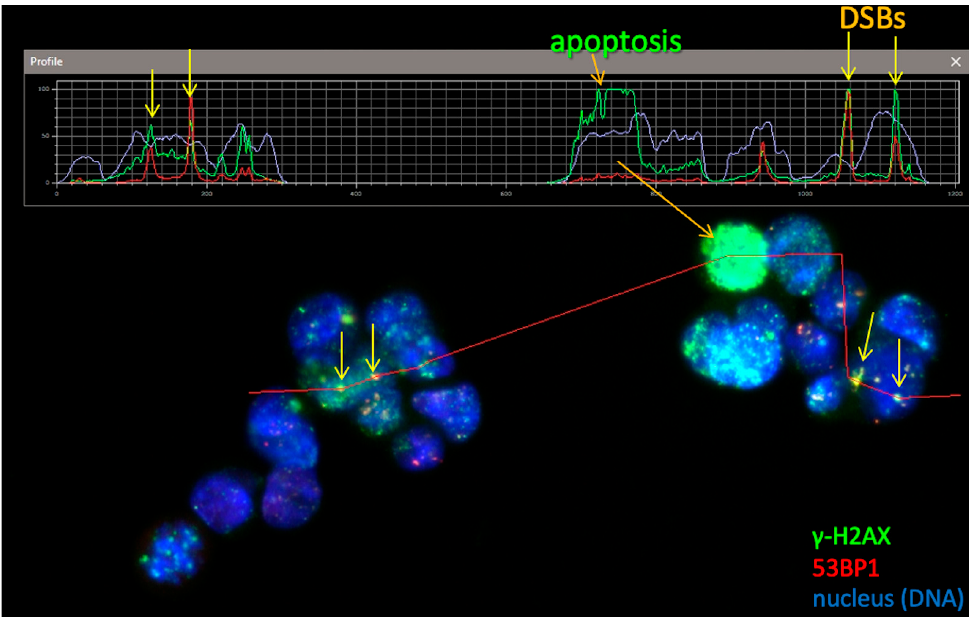
Figure 2. DSB focus analysis in HOB cells via γ H2AX+53BP1-positive DNA DSB foci detection. The upper part of the image shows intensity profiles along the red line below across 6 nuclei (DNA, blue). γ H2AX-positive foci are shown in green, 53BP1 in red. Colocalized foci are a surrogate marker for DSBs and are marked with yellow arrows. Apoptosis can be seen as pan-nuclear γ H2AX staining in absence of 53BP1.